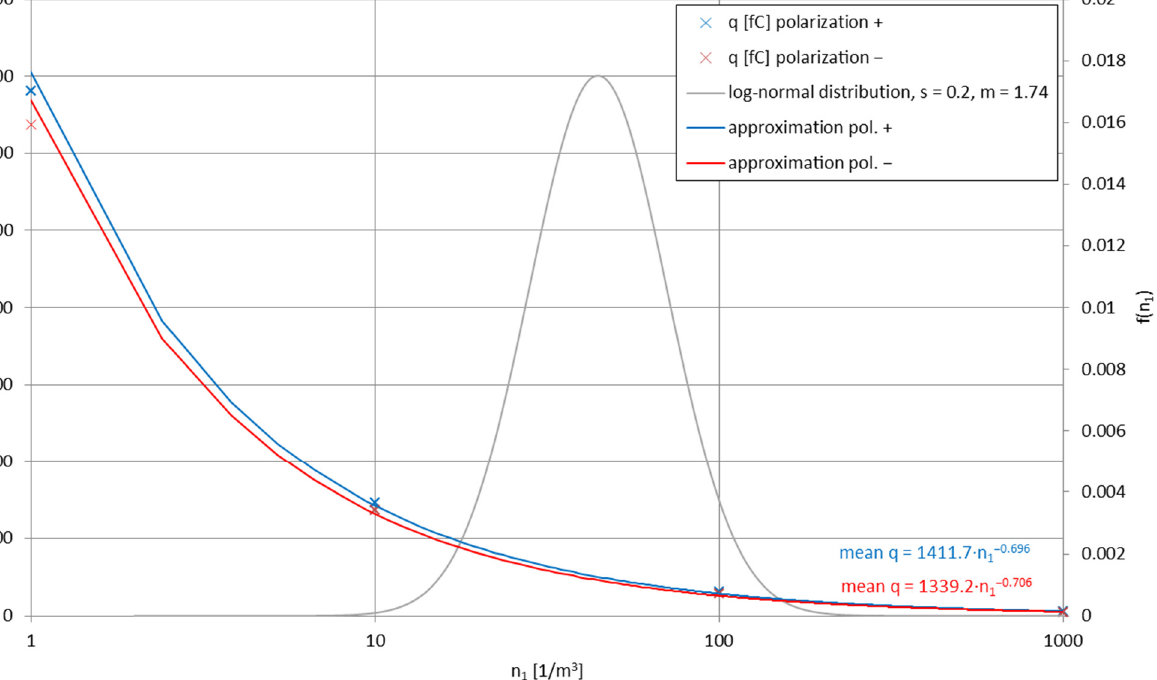
Figure 8. The amounts of talc powder forming a uniform layer on the spherical electrode (as in Figure 5), seen at 100× magnification (PZO Poland microscope). As this parameter is a product of the particles’ accumulation linearly at time t acc . for the n 2 particle concentration (which increases in value with the voltage across the air gap, as more particles are expulsed), a function of it can be formulated: 𝑛 (cid:3032)(cid:3039). = 1 2 𝑡 (cid:3028)(cid:3030)(cid:3030). 𝑛 (cid:2870) = 1 2 𝑡 (cid:3028)(cid:3030)(cid:3030). 𝑛 (cid:2869) 𝑈 (cid:2870) 𝑈 (cid:2869) (cid:4670)𝑚 (cid:2879)(cid:2870) (cid:4671)